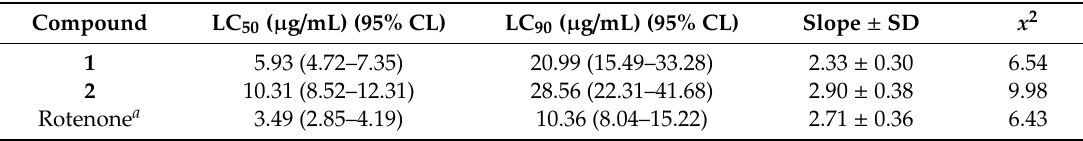
Table 3. Larvicidal activities of 1 and 2 against Aedes aegypti